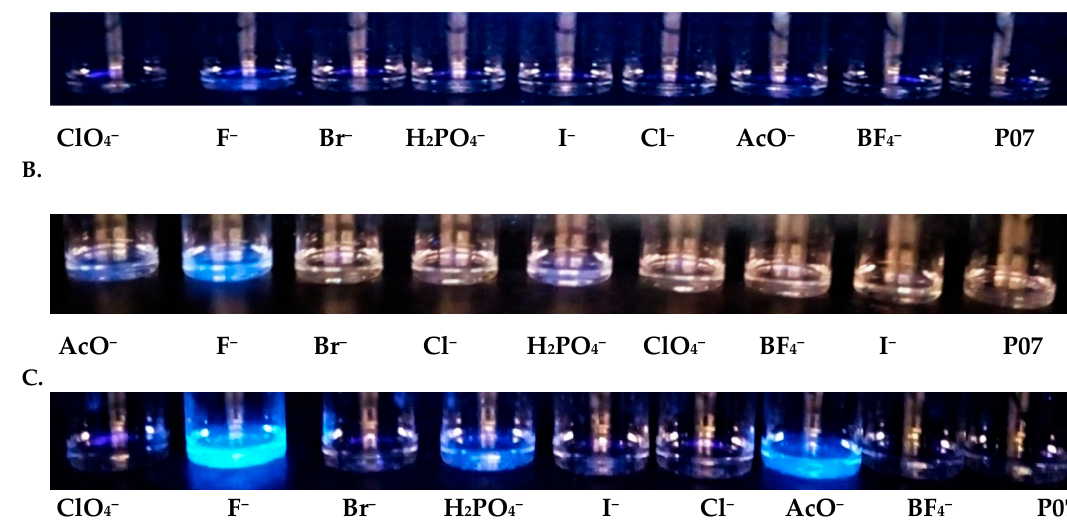
Figure 3. Response of P07 (solvent: toluene) with P03 loadings of ( A ) 0.1 mol% , ( B ) 1.0 mol% , and ( C ) 10.0 mol% to TBA salts (Concentration of stock solution: 1.98 × 10 − 3 M, solvent: acetonitrile) under UV light (365 nm). Volume of anion solution: Volume of P07 solution, 1:1.